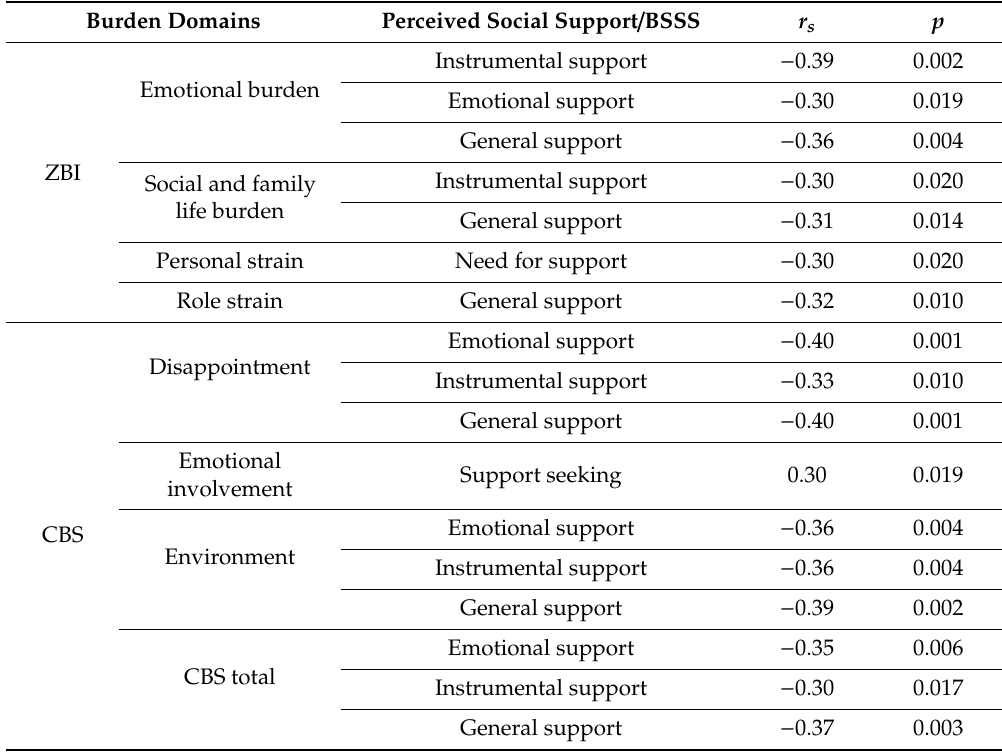
Table 3. Correlations of the caregiver burden (ZBI and CBS) and the perceived social support (BSSS) in the group of male partners of the women with